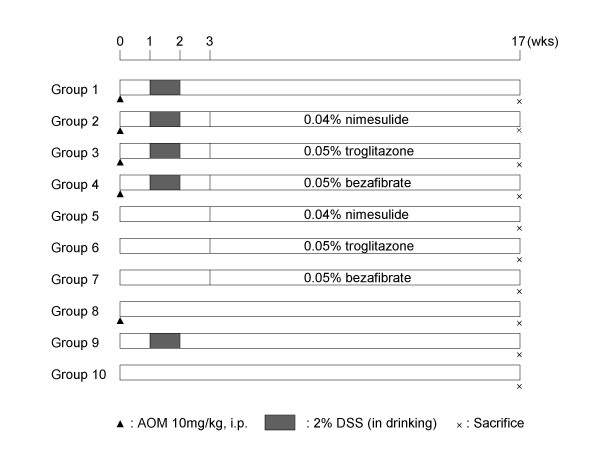
Experimental protocol. Arrows, AOM 10 mg/kg body weight, i.p. injection; densely cross-hatched bars, 2% dextran sodium sulfate (DSS) in drinking water; open bars, basal diet and tap water; crosses, death.